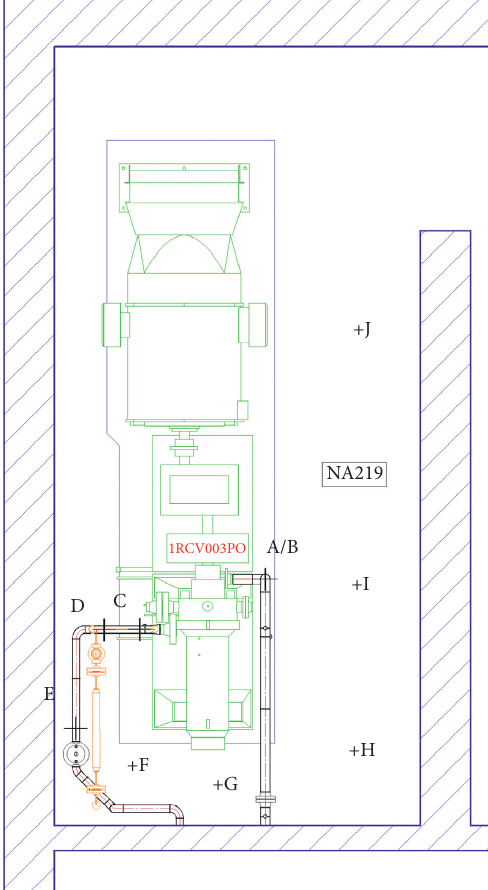
Figure 3: Positions of dose rate measurement points in selected typical radiological